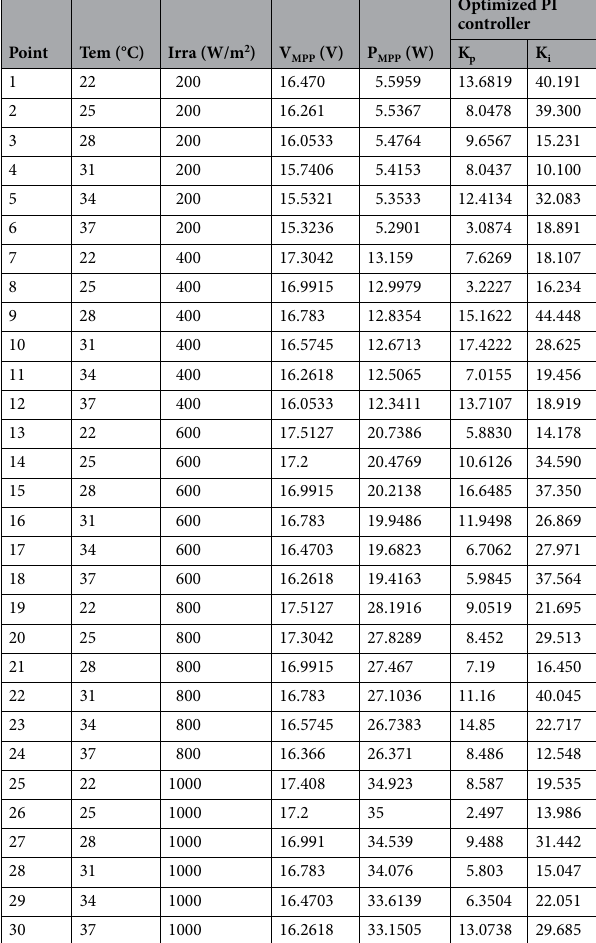
Table 2. Temperature, irradiance PV voltage and power at MPP and the control parameters.